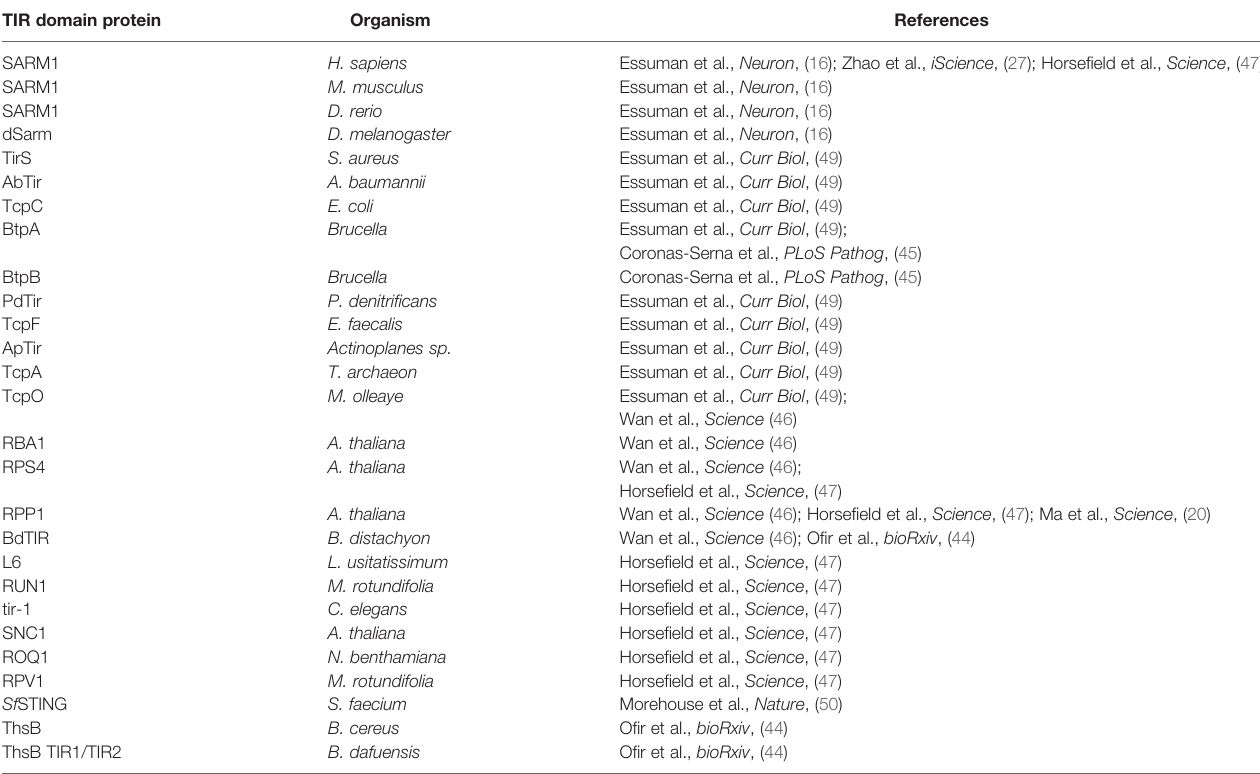
TABLE 1 | TIR domain-containing proteins with demonstrated intrinsic NADase activity. TIR domain